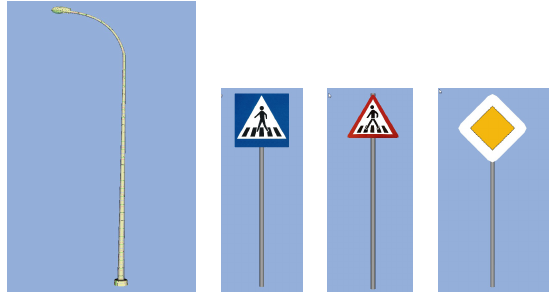
Figure 2. 3D models for SAR simulation.